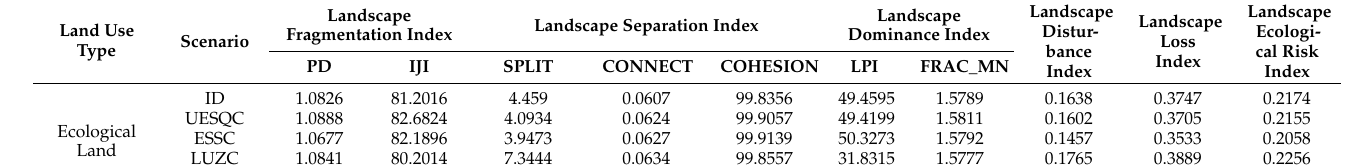
narios and compared it horizontally in order to describe the characteristics of landscape ecological risk aversion ability under different planning control methods. The results showed that the landscape fragmentation index of construction land was the highest in the urban expansion size quantity control scenario; the landscape frag-